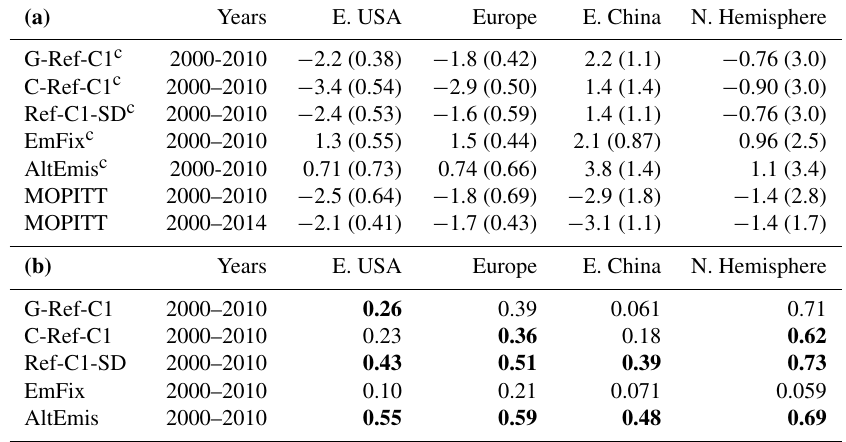
Table 2. Regional trends and correlations: (a) trends a , b and (b) correlation coefficient ( r ) with monthly MOPITT anomalies d , e .